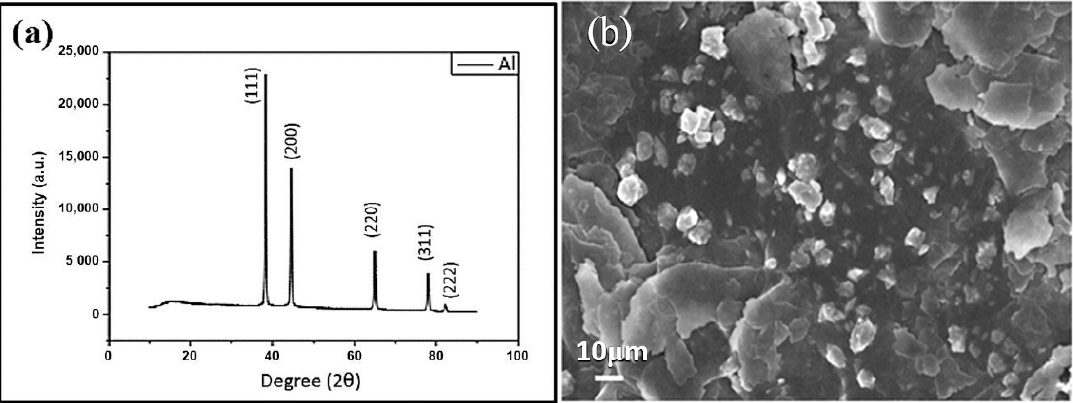
Figure 13. ( a ) XRD and ( b ) SEM image for the Al powder.